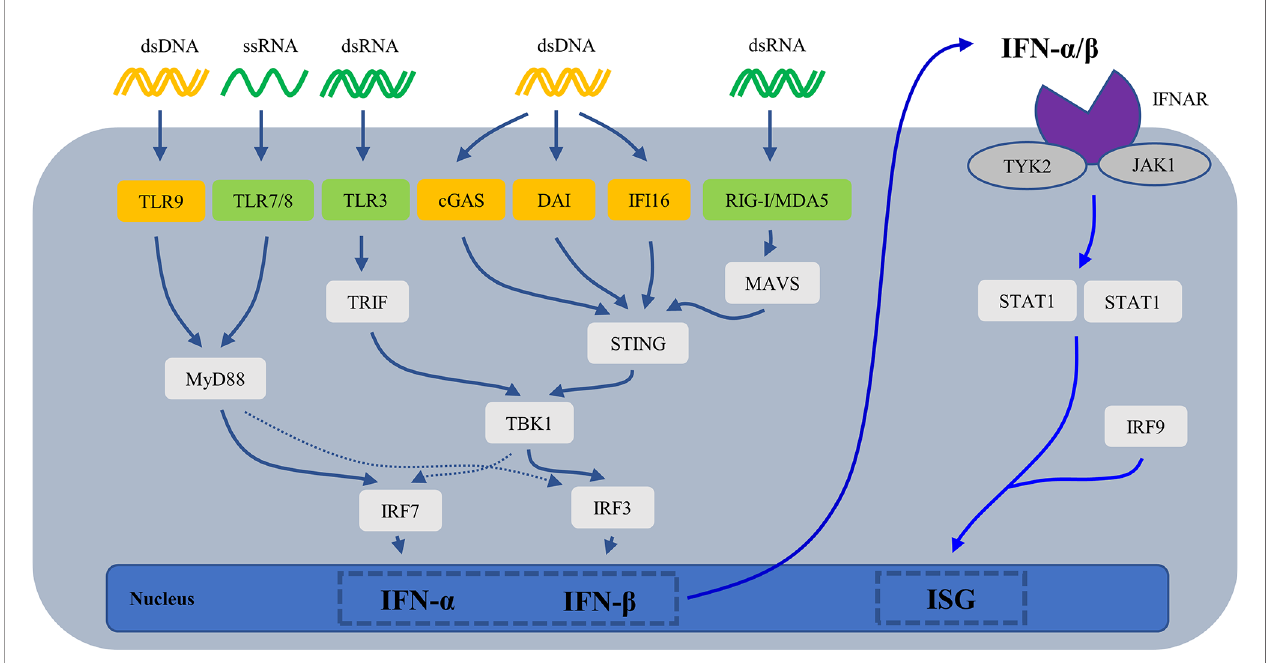
FIGURE 3 | The mechanisms for generation of IFN-I. cGAS, cyclic GMP-AMP (cGAMP) synthase; DAI, DNA-dependent activator of IFN-regulatory factors; IFI16, interferon-inducible protein 16; IFN, interferons; IFNAR, type I interferon receptor; ISG, IFN-stimulated gene; MAVS, mitochondrial antiviral signaling; MDA5, melanoma differentiation-associated protein 5; RIG-I, retinoic acid-inducible gene I; STING, stimulator of interferon genes; TBK1, TANK-binding kinase 1; TLR, Toll-like